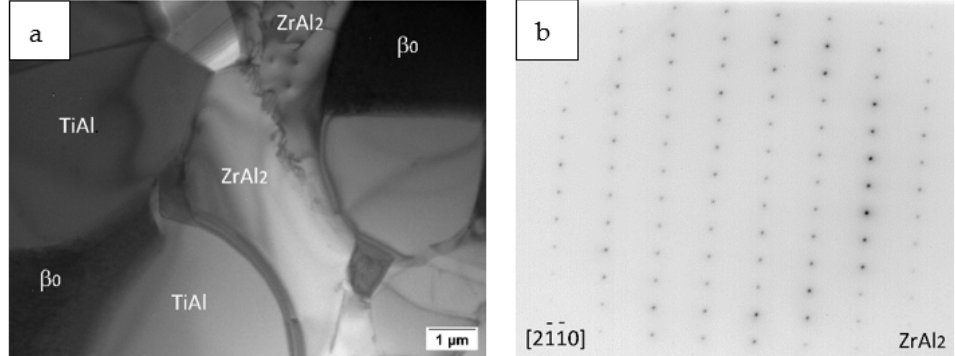
Figure 2. HE-XRD analysis of Z4 (Ti-44.7Al-16.5Zr at. %) heat treated at 1000 °C/100 h.